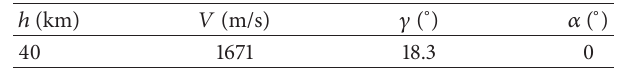
Table 4: Simulation results.